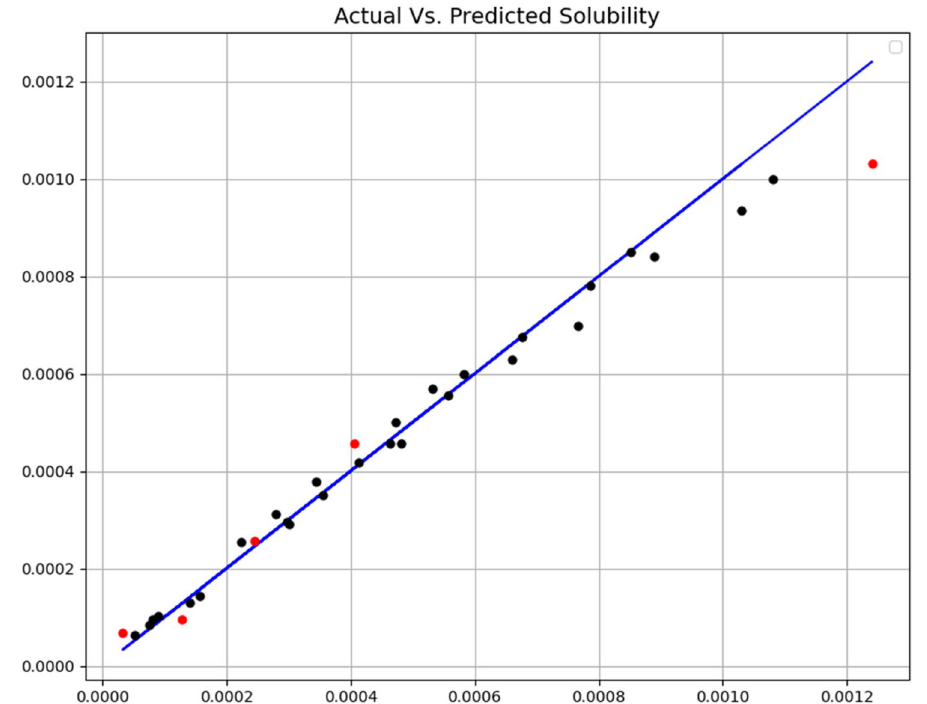
Figure 4. Expected and predicated solubility (RF model).